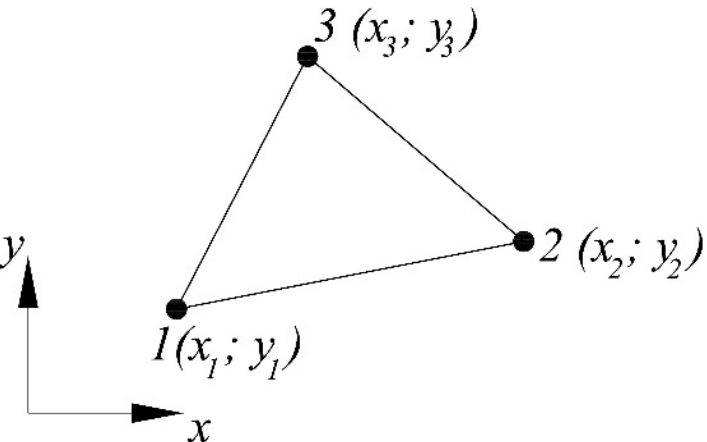
Figure 2. Plane triangular FE for concrete modeling.